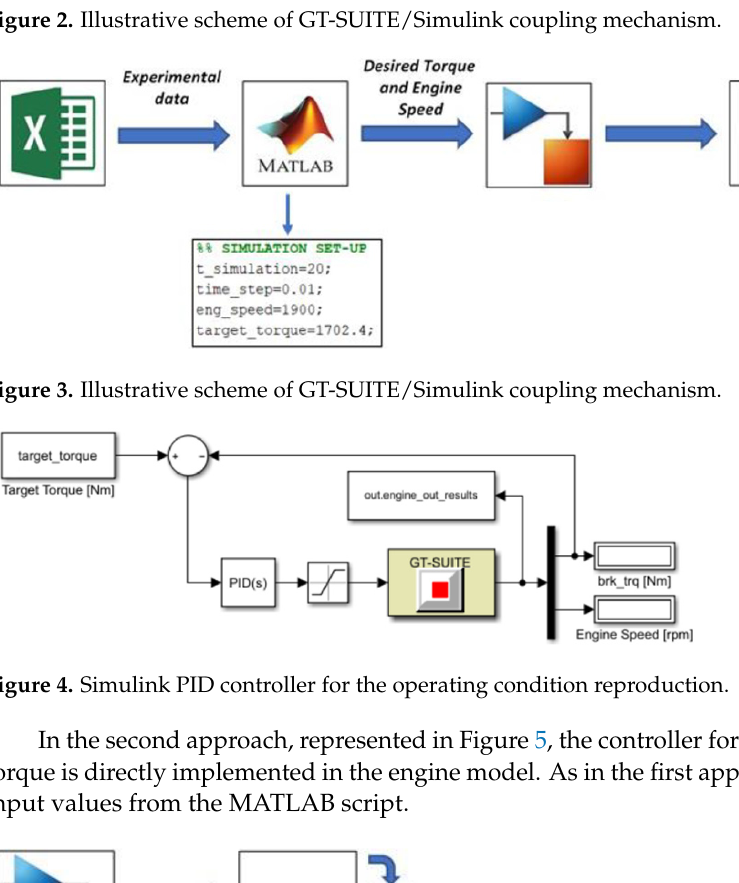
Figure 2. Illustrative scheme of GT-SUITE/Simulink coupling mechanism.